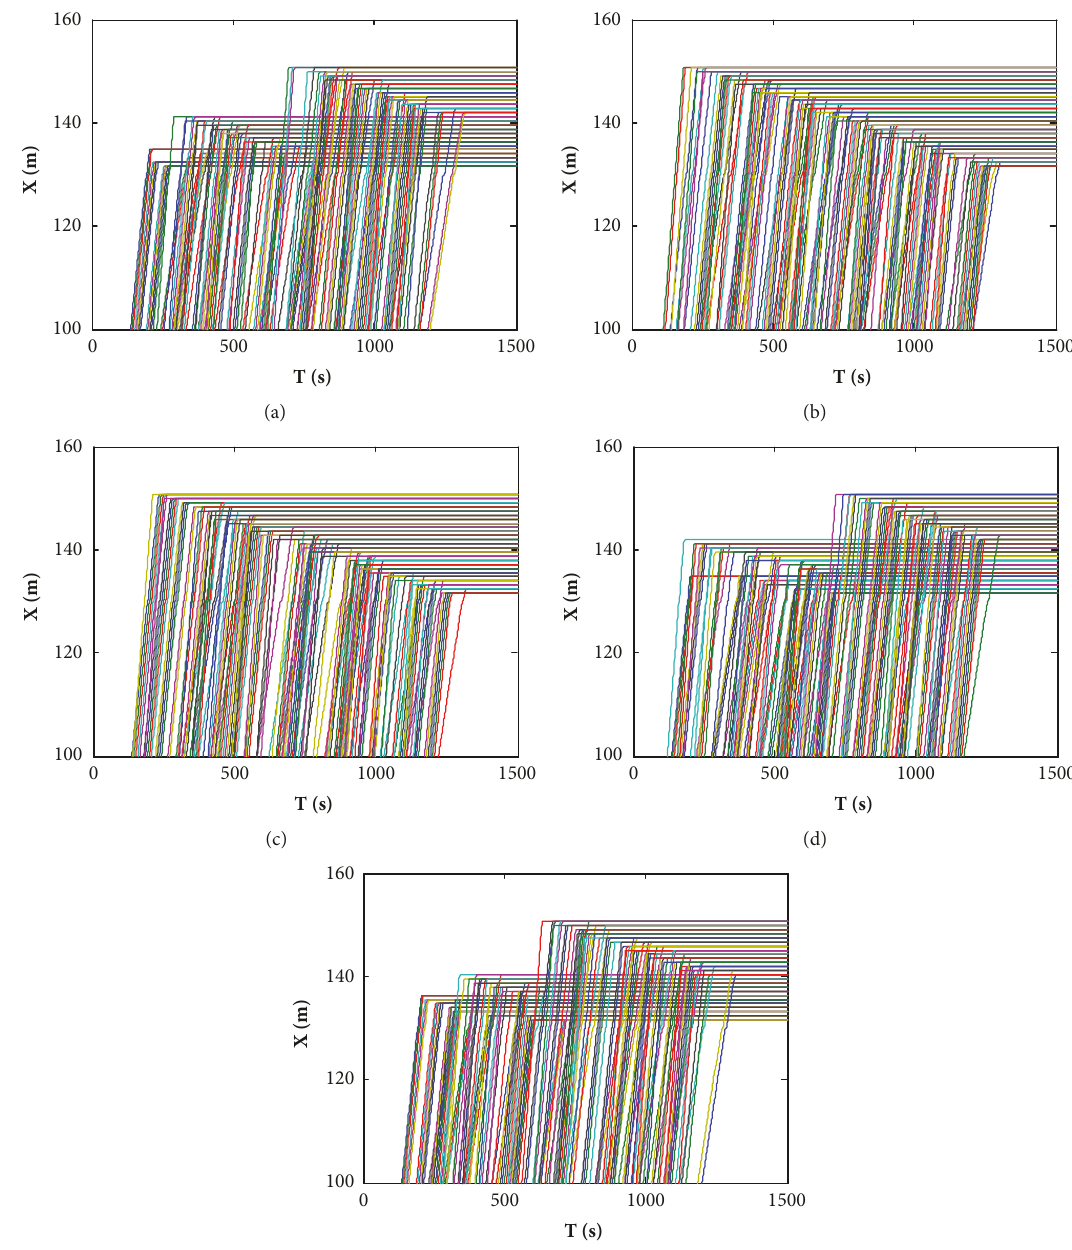
Figure 5: Each passenger’s trajectory during the boarding process, where (a)-(e) are, respectively, the random strategy, BF strategy, Wilma strategy, Steffen strategy, and proposed